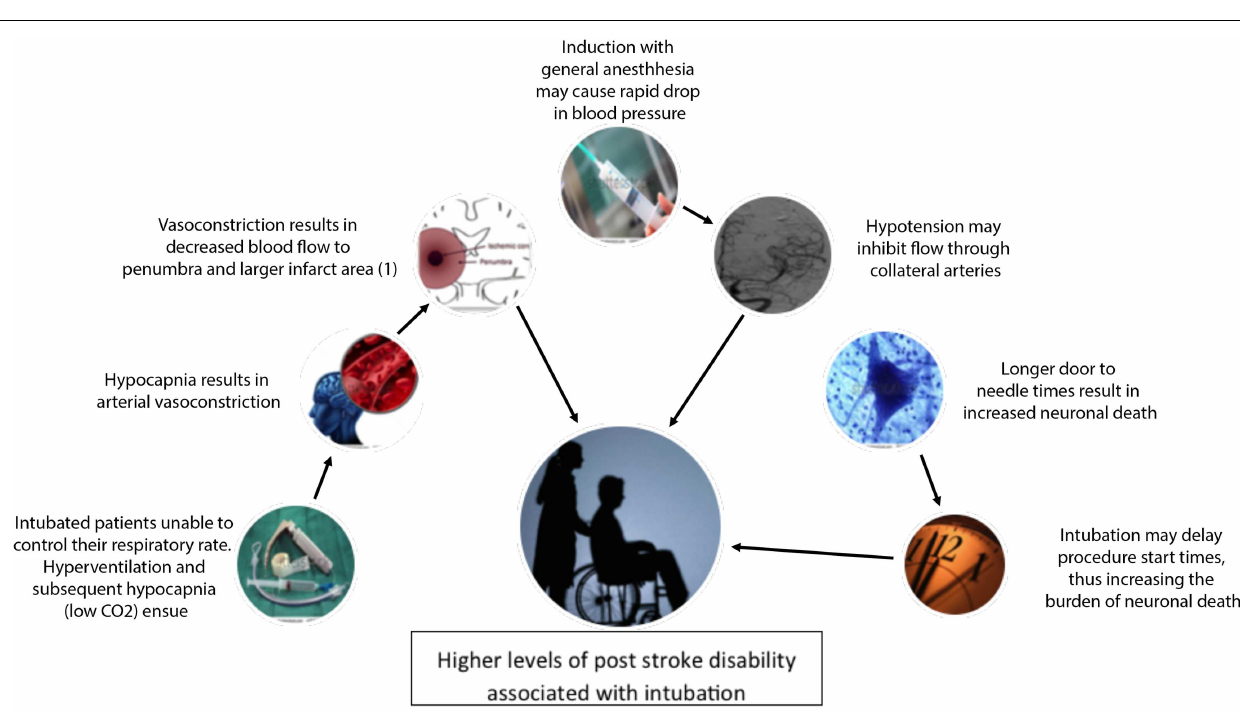
FIGURE 1 | Diagram of proposed relationships between general anesthesia and observed higher levels of post stroke disability. (1) Reprinted by permission from Macmillan Publishers Ltd: Acta Pharmacologica Sinica, Reference 3460241439635 copyright 2011.